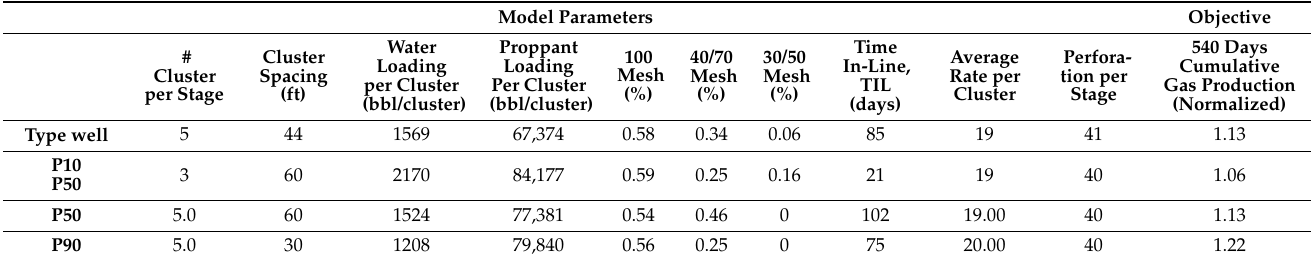
Table 6. Field completion design